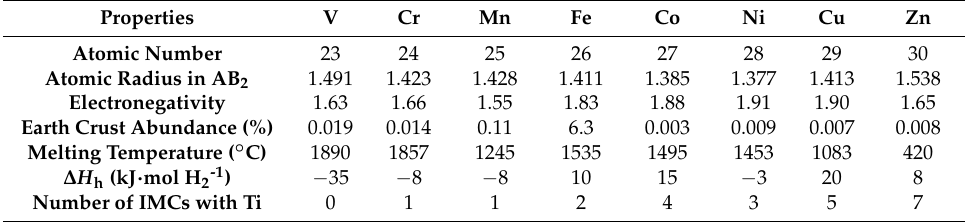
Table 6. Properties of first-row transition metal elements as B-site atoms in AB 2